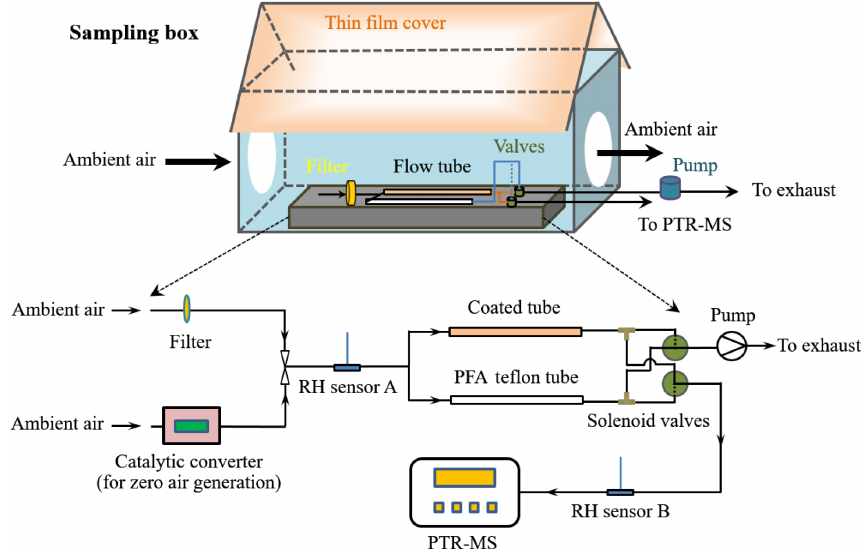
Figure 1. Schematic illustration of the experimental setup.